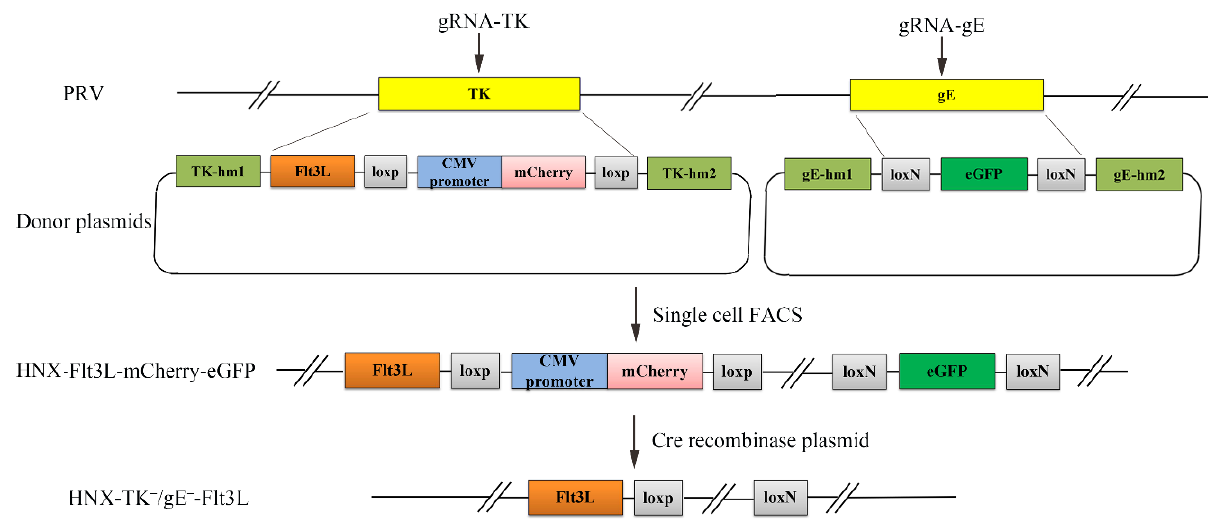
Figure 1. Schematic diagram of the recombinant pseudorabies virus (PRV) development strategy. The PRV virulence-related genes TK and gE were simultaneously replaced via the CRISPR/Cas9 system by using DNA templates that included fluorescent marker genes (mCherry and eGFP) and the Flt3L gene. Then, single cell fluorescence-activated cell sorting (FACS) was used to accelerate the screening and purification of the recombinant PRV virus. Subsequently, both fluorescent marker genes were excised using the Cre/Lox system.